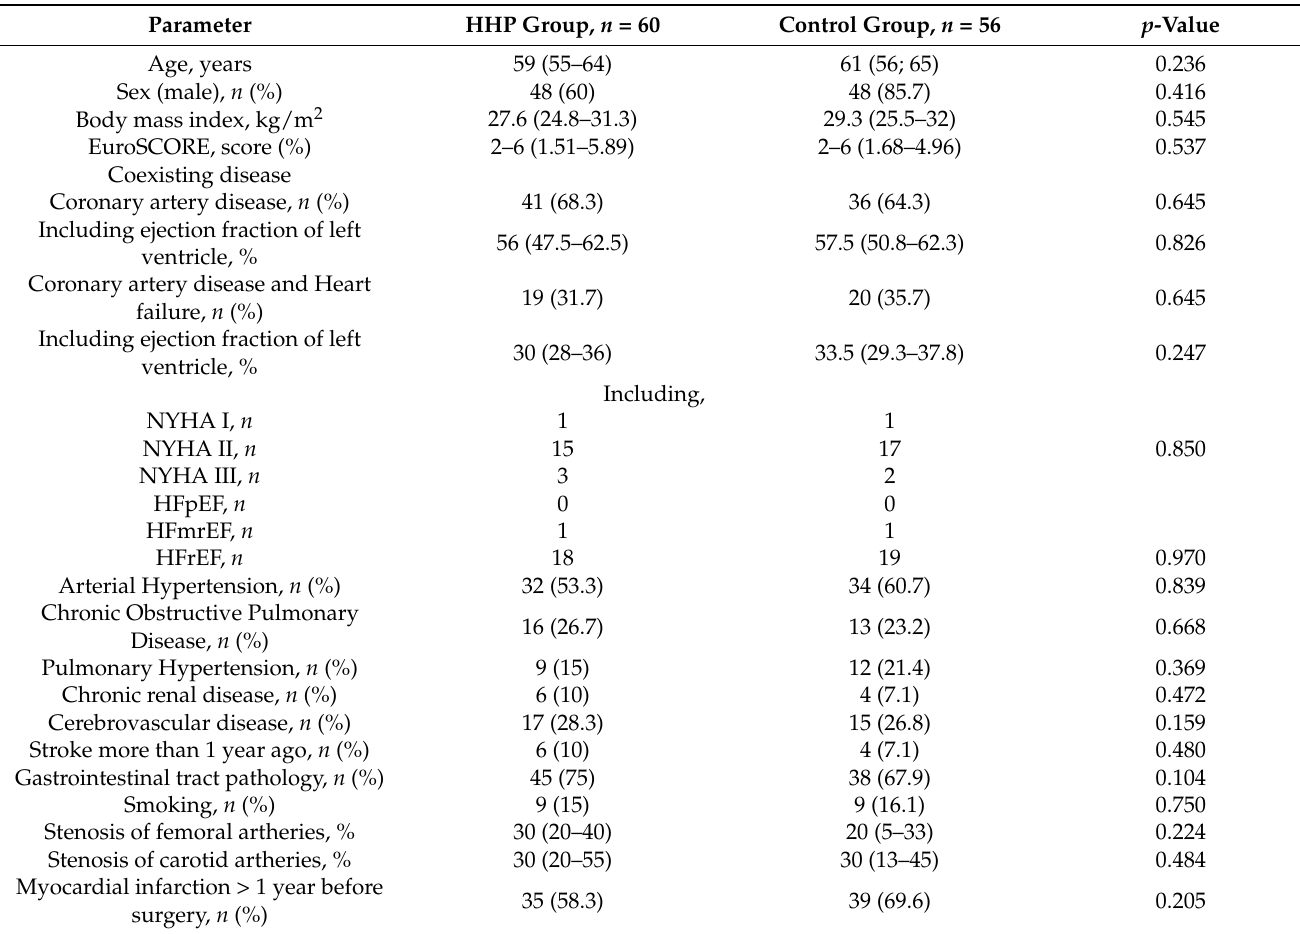
Table 1. Demographic and clinical characteristics of the